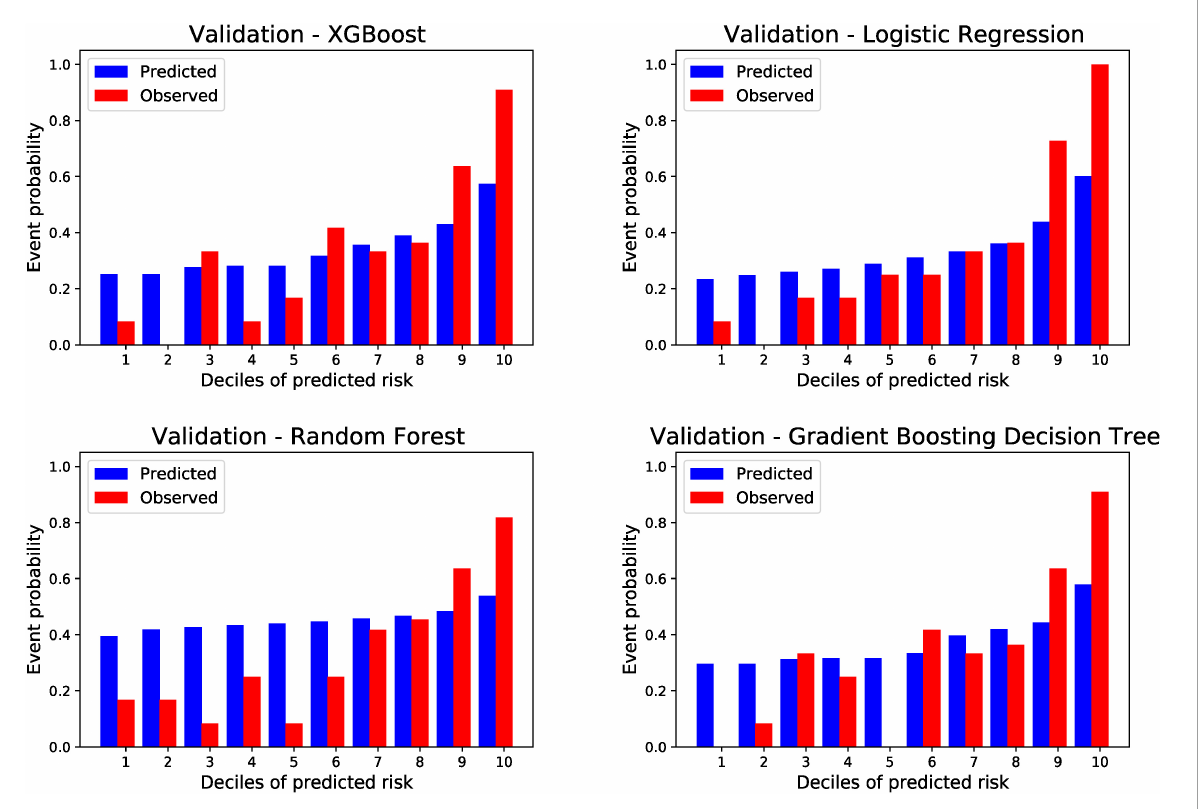
FIGURE4 Risk of post-thrombotic syndrome within 24 months according to deciles of event probability based on four machine learning models in the validation cohort. PTS, post-thrombotic syndrome; ML, machine learning; XGBoost, eXtreme gradient boosting.